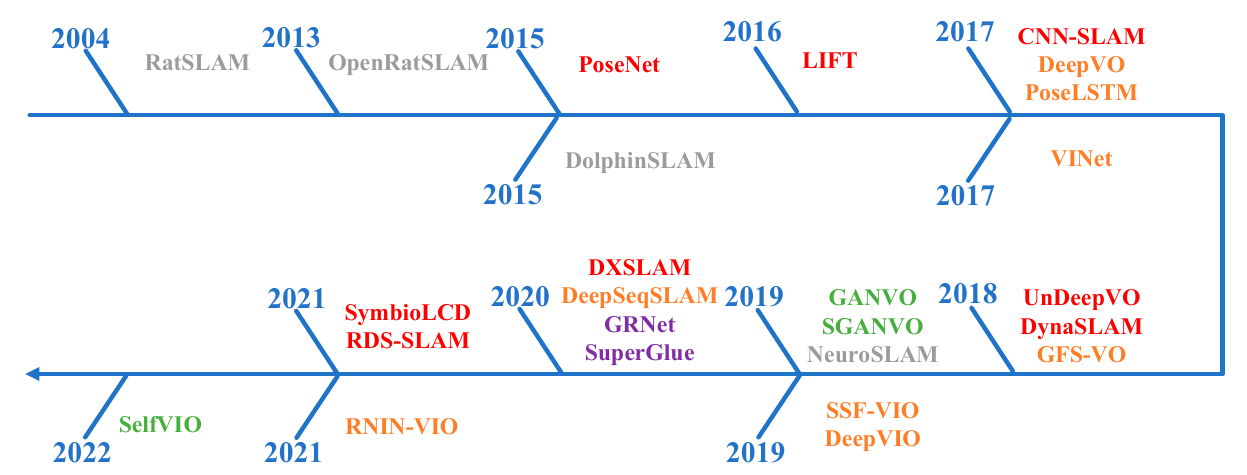
Figure 4. Overview of SOTA deep learning-based methods. The methods above the timeline represent vision-only methods, while those below the timeline represents vision-based multi-sensor fusion methods. Among them, red represents CNN-based methods, orange represents RNN-based methods, green represents GAN-based methods, purple represents GNN-based methods, and gray represents SNN-based methods.